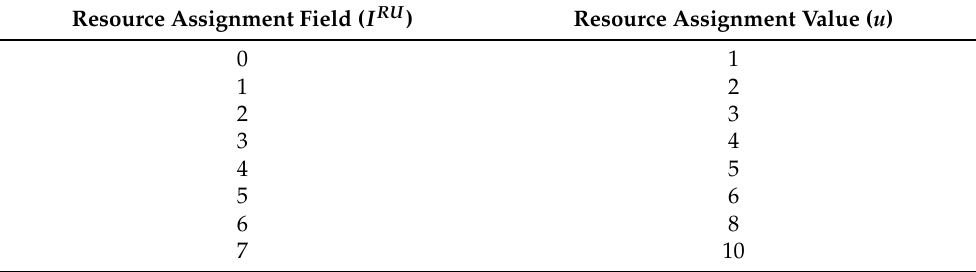
Table 7. The supported uplink resource assignment in